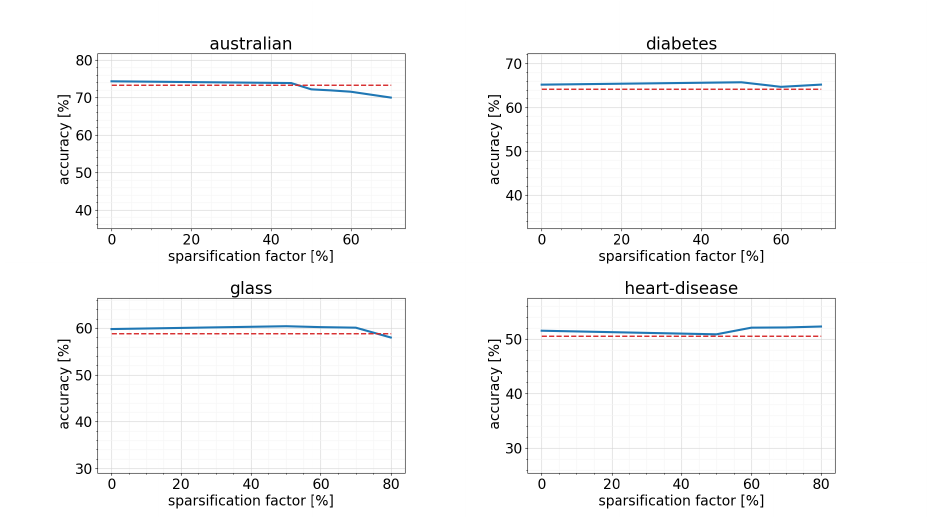
Figure 15. Results of pruning DT structure on Australian, diabetes, glass and heart-disease datasets.